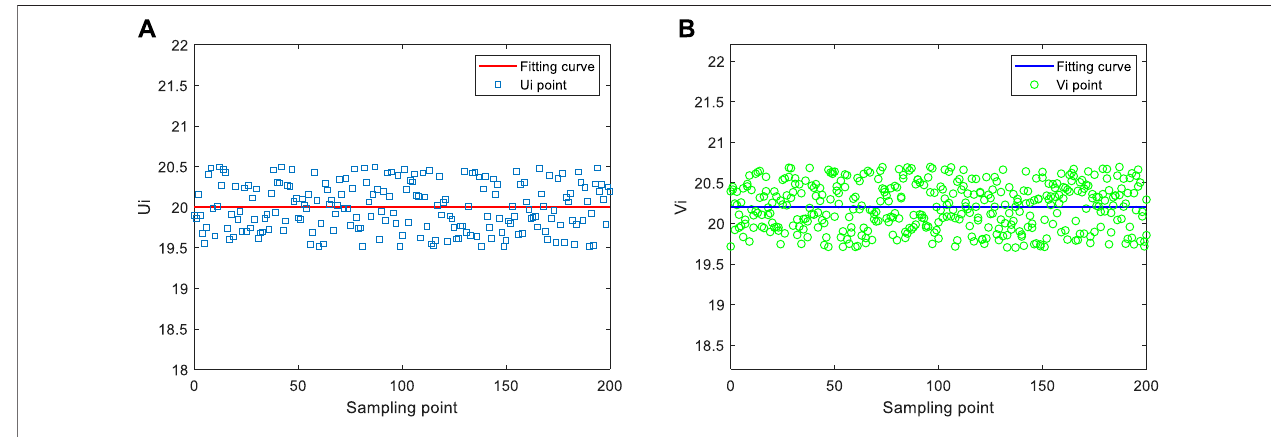
FIGURE 7 | The random delay distribution diagram of the link layer. (A) Ui data fi tting. (B) Vi data fi tting.